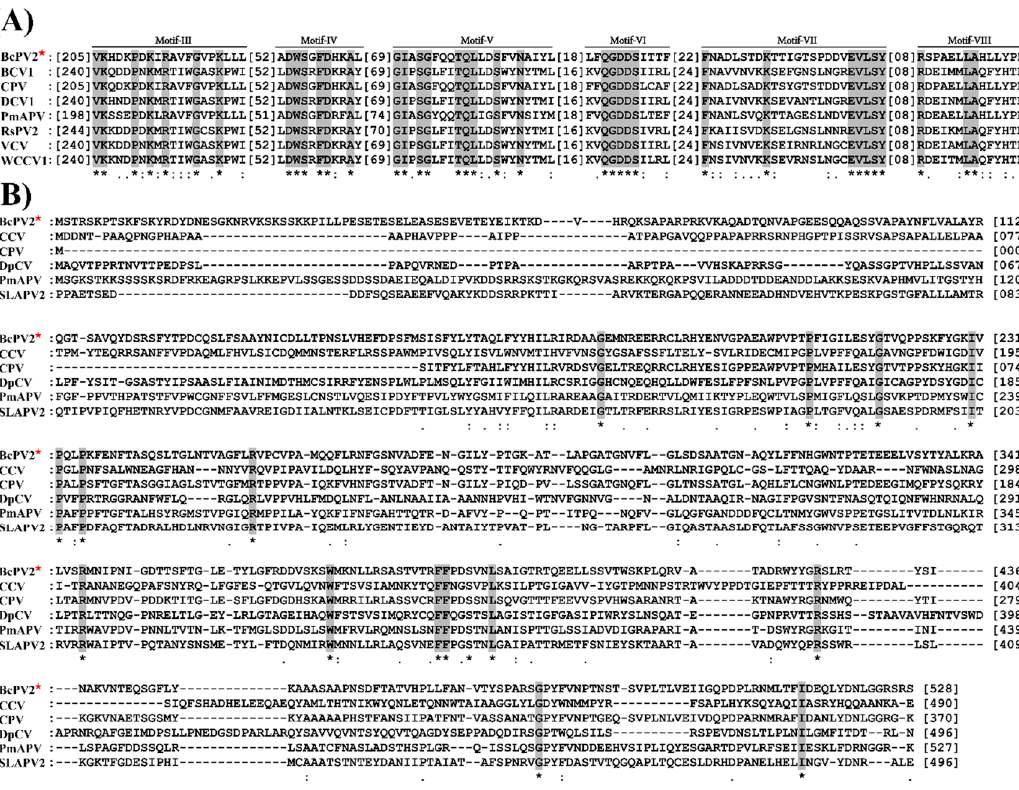
Figure 6. Multiple alignments of the amino acid sequences of RNA-dependent RNA polymerase and coat protein of BcPV2 with other selected members in Alphapartitivirus . ( A ) Amino acid sequences of RNA-dependent RNA polymerase (RdRp); and ( B ) amino acid sequences of coat protein (CP). “*”, identical amino acids, “:” and “.” high and low chemically similar amino acids, respectively. Note the five conserved motifs (Motif-III to Motif-VIII) in RdRp and diversified CP sequences among the compared viruses. Abbreviations: BCV1, Beet cryptic virus 1; BcPV2, Botrytis cinerea partitivirus 2; CCV, carrot cryptic virus; CPV, Ceratobasidium partitivirus; DCV1, Dill cryptic virus 1; DpCV, Diuris pendunculata cryptic virus; PmAPV, Powdery mildew-associated partitivirus; RsPV2, Rhizoctonia solani partitivirus 2; SLAPV2, Soybean leaf-associated partitivirus 2; VCV , Vicia cryptic virus; WCCV1, white clover cryptic virus 1. The GenBank accession numbers for RdRp and CP of the above-mentioned viruses are listed in Table S2.